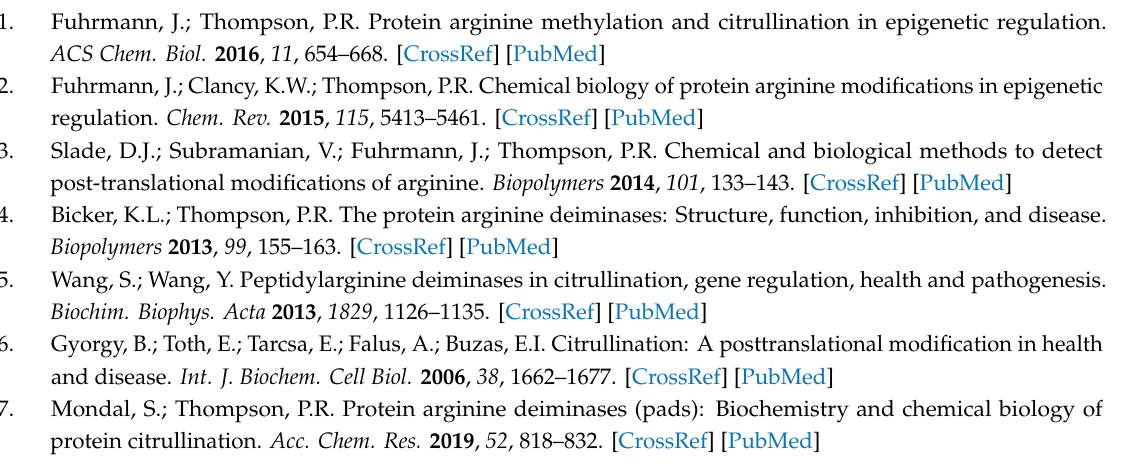
Figure S1: Restriction enzymes and associated restriction pattern identified to be suitable for the detection of SNPs in the PADI4